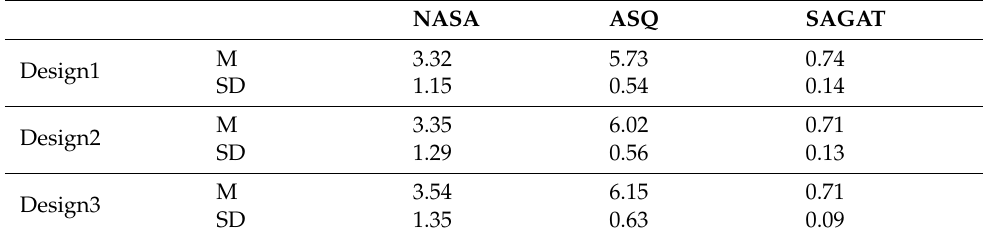
Table 2. Questionnaire results for the three designs ( n = 16).